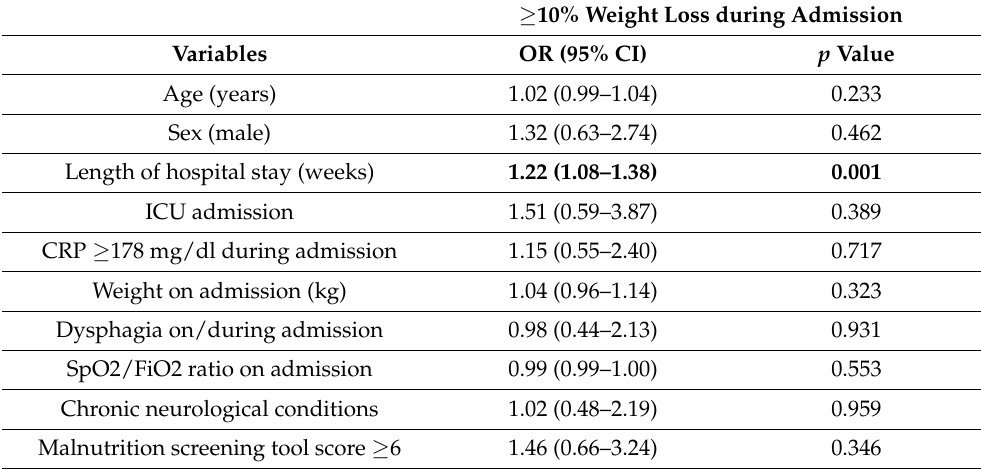
Table 4. Multivariable binary logistic regression for risk factors of ≥ 10% weight loss during admission.